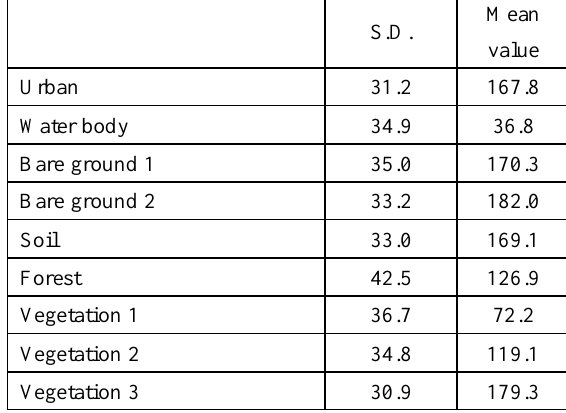
Table 1 Mean value and S.D. of thermal band